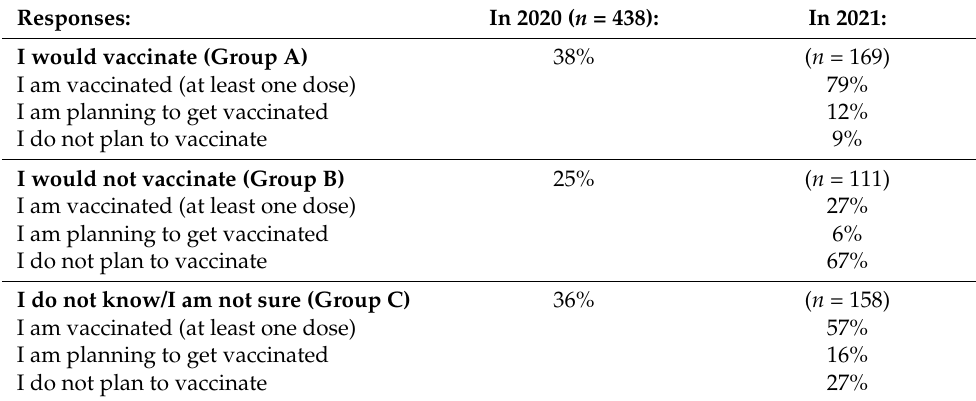
Table 1. Intention to vaccinate (2020) versus actual vaccination acceptance (2021).